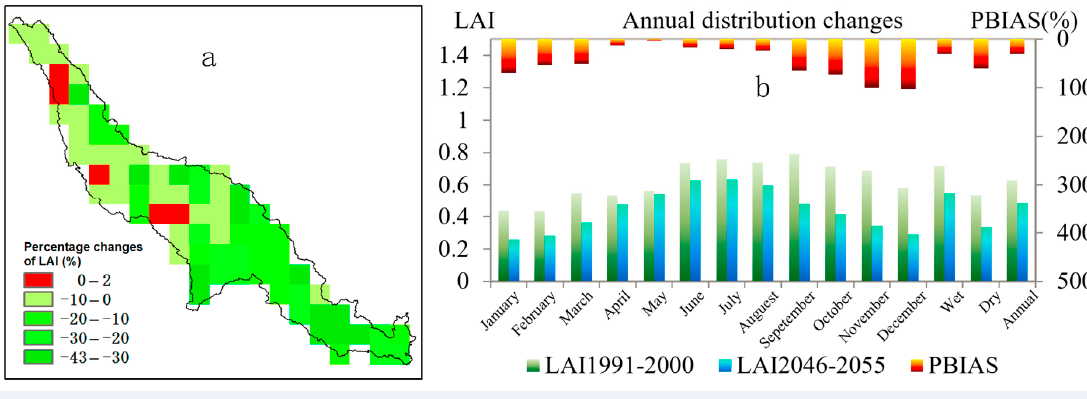
Figure 5. Spatial distribution of percentage changes in LAI ( a ) and annual distribution changes ( b ) in LAI.